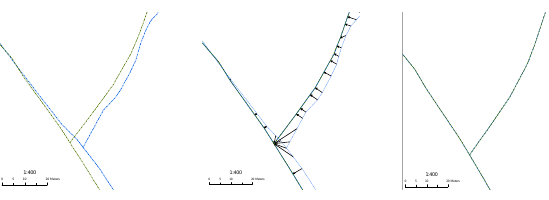
Figure 8: Polygonal databases alignment: cadastre (dashed blue) and topographic (dashed green): before (top) and after (bottom)